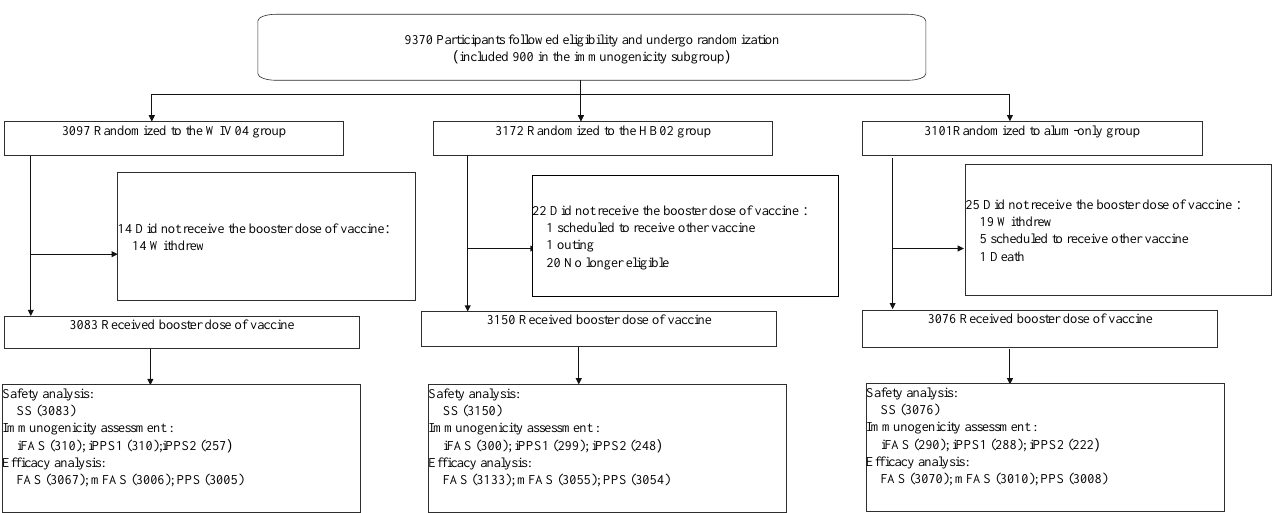
Figure 1. Flow of Participants. See eMethod in Supplement for definitions of each analysis population.